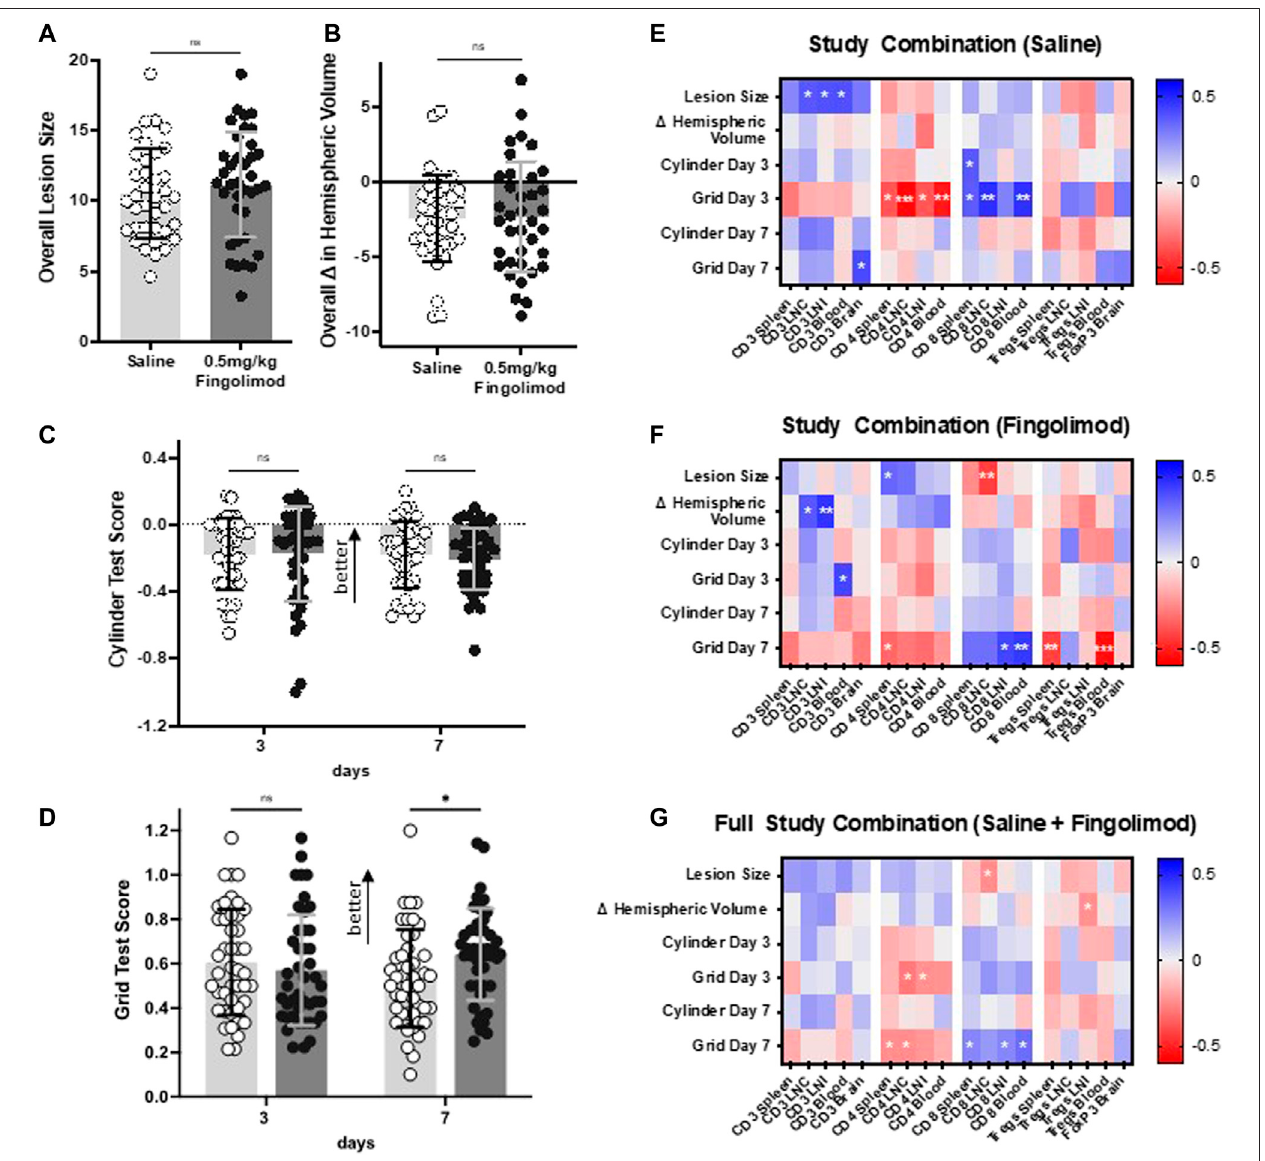
FIGURE7| Resultsfromcombinedstudies(doseresponse,aged,atheroscleroticmice)showingeffectofdailysalineor0.5 mg/kg fi ngolimodon (A) lesionsize, (B) differenceinhemisphericvolumes, (C) cylindertestresults, (D) gridwalkingtestscore( n =37perdrugtreatmentgroup). E – G :Correlationmatrixbetweentheproportion of T lymphocytes and experimental outcomes. Heat map depicting correlations between lymphocyte proportions and experimental outcomes (infarct volume, hemispheric volume, and cylinder/foot fault scores at days 3 and 7) for (A) all young, aged, and ApoE − / − mice, (B) saline-treated mice, and (C) fi ngolimod-treated mice. Colours represent Pearson r value on a scale from − 0.6 to +0.6, as indicated on the lookup tables on the rights. For statistical signi fi cance, * p < 0.05, ** p < 0.01, *** p < 0.001.